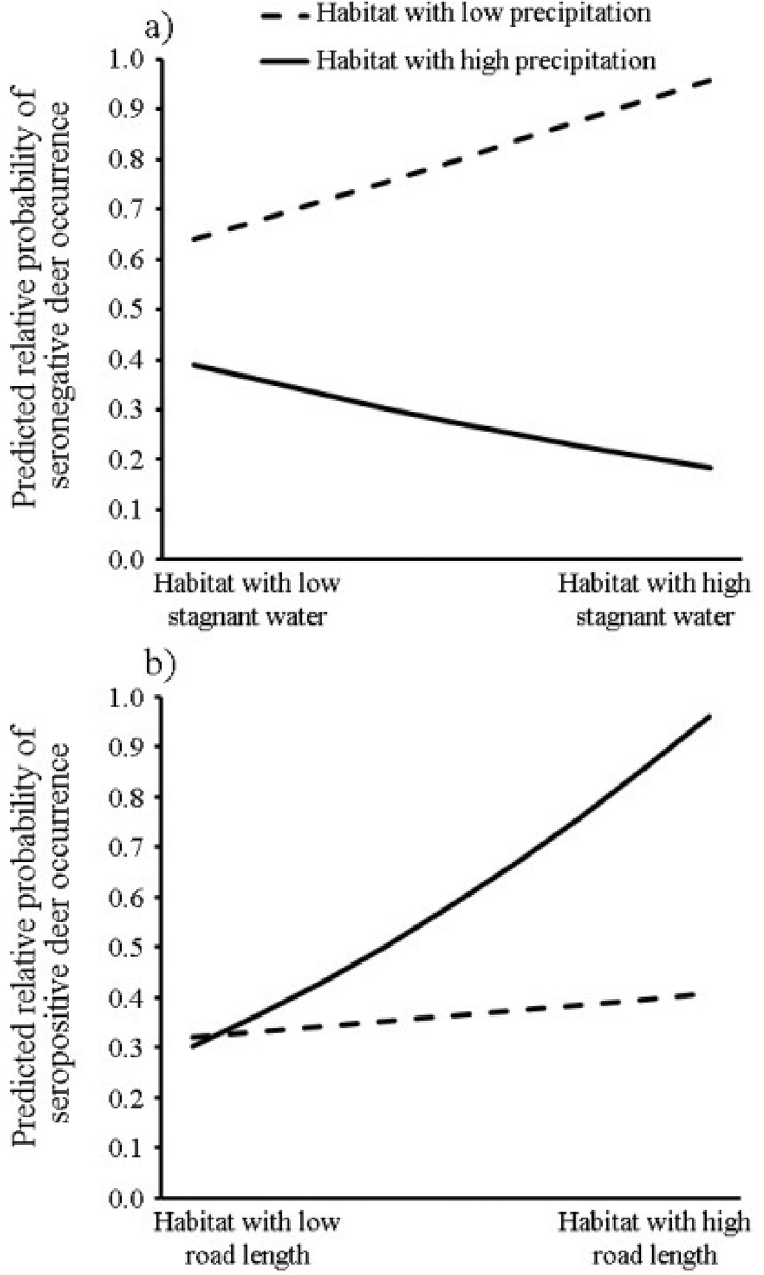
Fig 2. Plots of the magnitude of effects for the interaction terms featured in the top-ranking models describing the resource selection of deer that were seronegative (panel a) and seropositive (panel b) for Jamestown Canyon virus, Cook County, Illinois